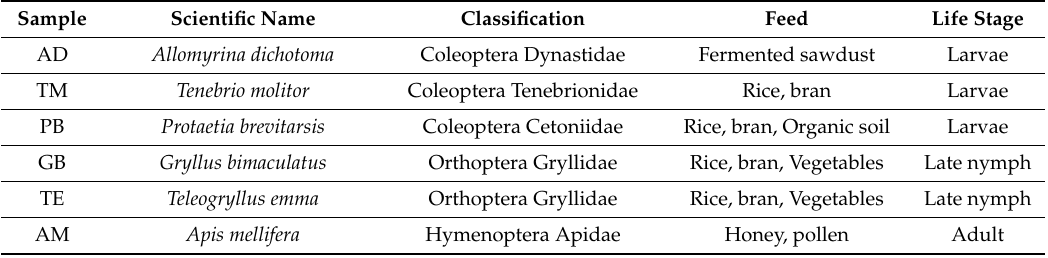
Table 1. List of preferred insects used as food, feed, and oriental medicine in